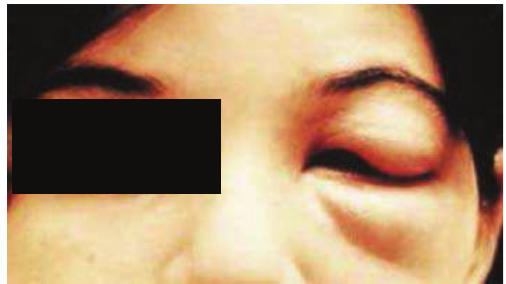
Figure 3: Romana’s sign is characterized by unilateral palpe- bral edema, conjunctivitis, and lymphadenopathy. Photograph is adapted from WHO/TDR